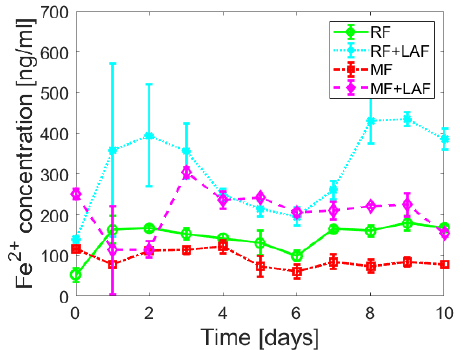
Figure 5. Time dependence of ferrous ion release (mean ± SD) from ferritin derivatives and during the interaction with LAF.